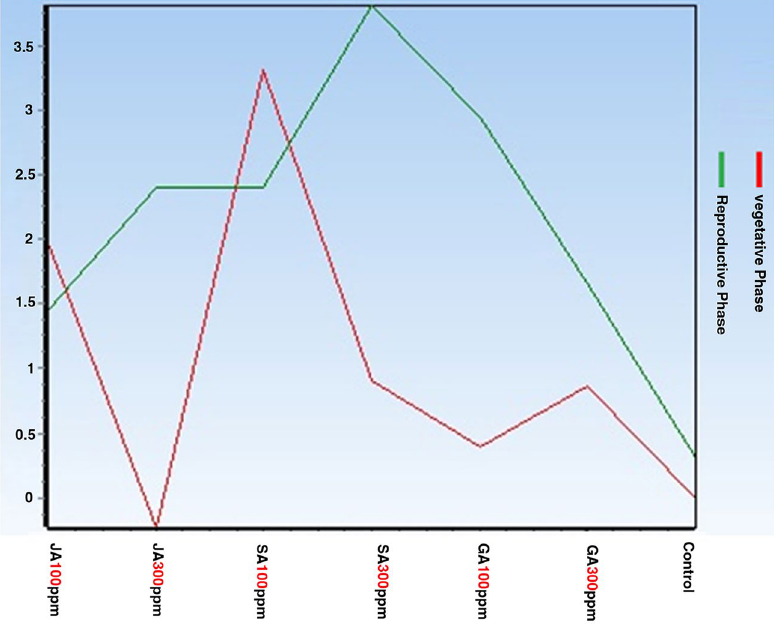
Figure 1. Changes in CHS gene expression in the aerial part under different hormonal treatments at different phenological